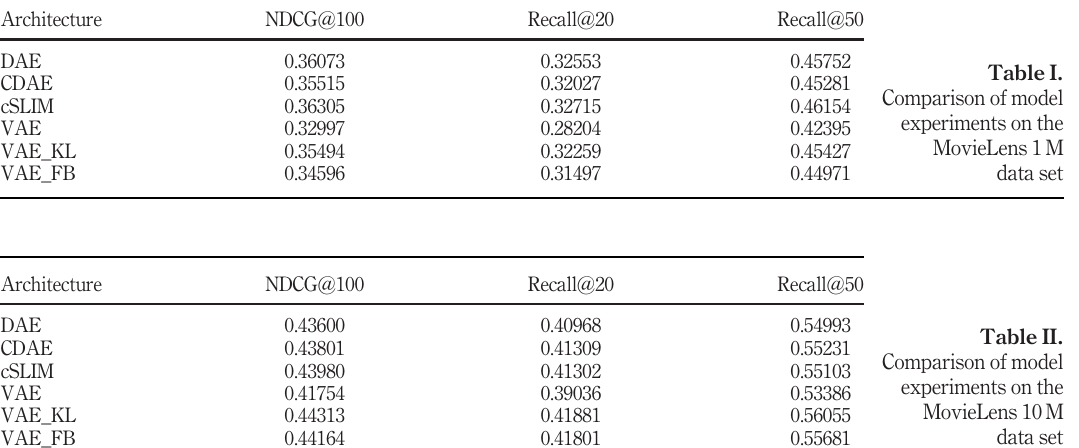
Table I. Comparison of model